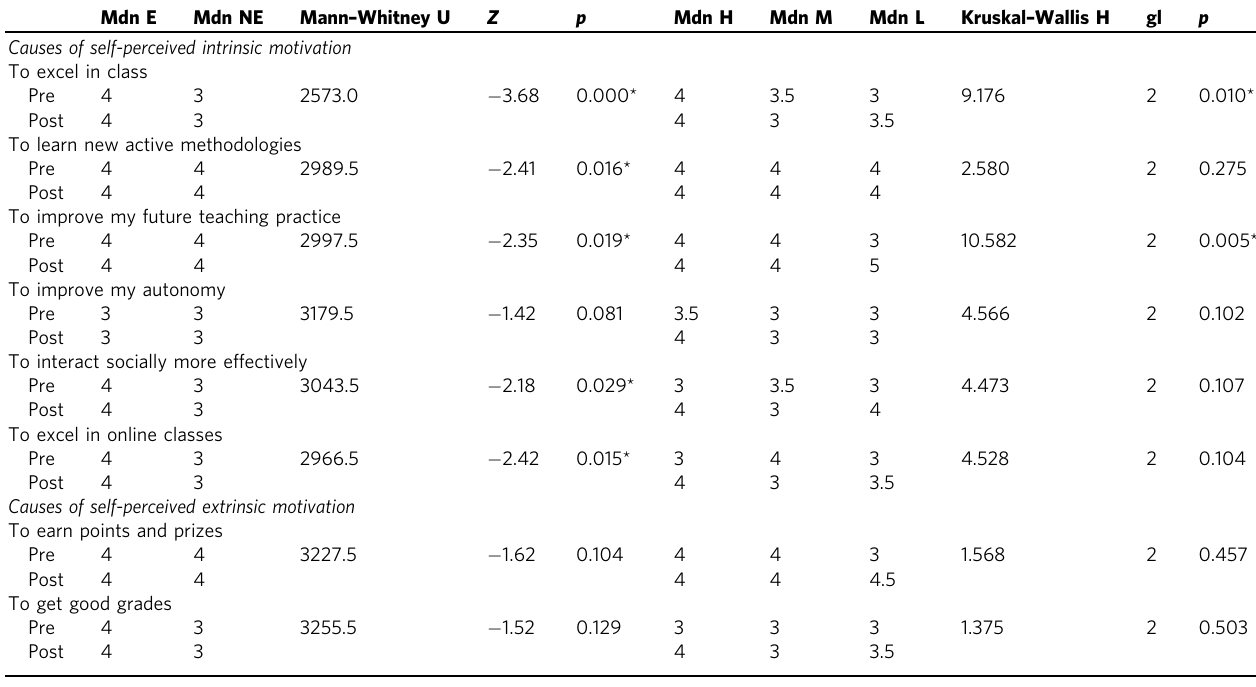
Table 2 Non-parametric results for the variables referring to self-perceived intrinsic and extrinsic motivation in this approach during the COVID-19